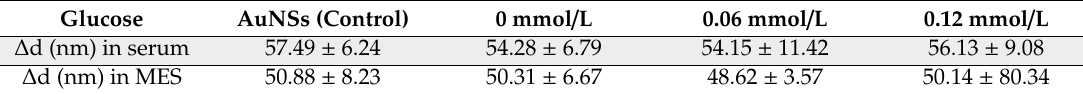
Table 1. Changes in AuNSs diameters corresponding to di ff erent glucose concentrations.